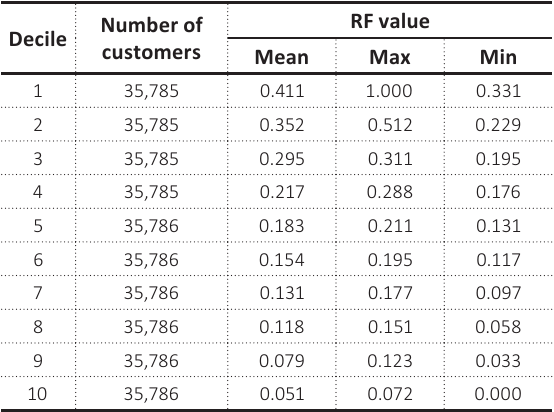
Table 2. RF value